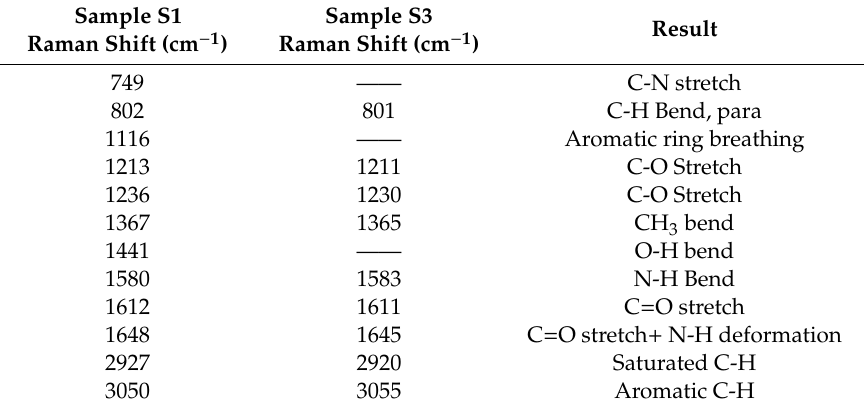
Table 2. Observed vibrational modes in the Raman spectra of sample S1 and S3.